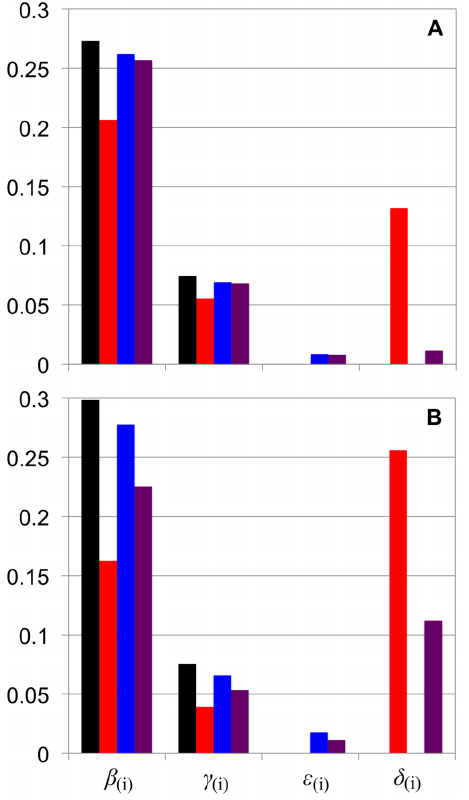
Figure 2. Enzymatic rate ratios from fitting Arabidopsis leaf starch CLDs in Figure 1 . The different color bars match those used for the different combinations of AMY and BAM in Figure 1: AMY – /BAM – (black); AMY – /BAM + (red); AMY + /BAM – (blue); AMY + /BAM + (purple). ( A ): Fitted enzymatic rate ratios for WT CLD; ( B ): that for Atisa1-1 CLD. Values of X 0(i) and X min(i) of 6 and 10, respectively, were used for all fits.